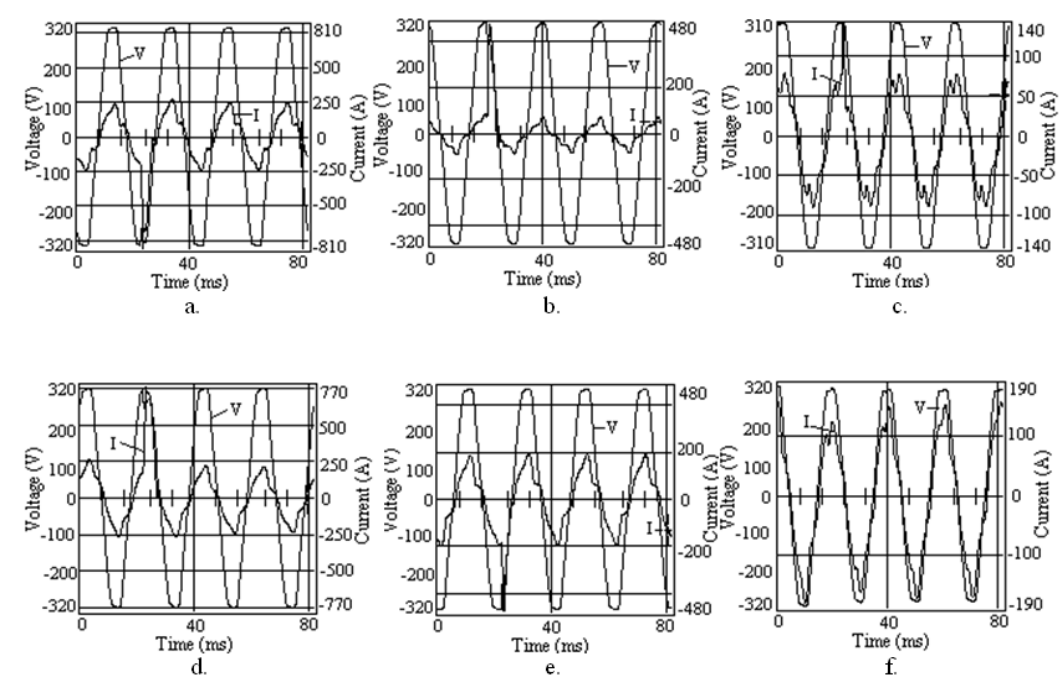
Figure 22. Current and voltage transients from the electrical power substation.